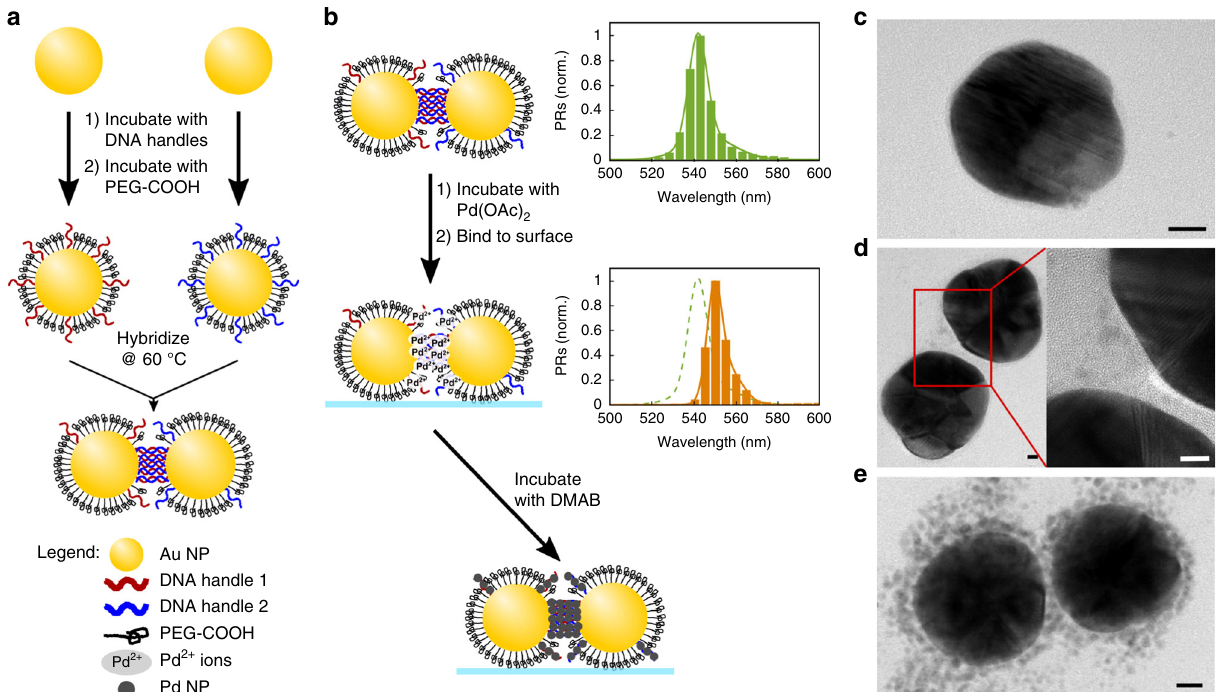
Fig. 1 DNA-guided growth of Pd NPs in plasmon rulers. a Model for plasmon ruler (PR) assembly from Au NPs functionalized with a low number of DNA molecules incorporated into a monolayer of PEG-COOH for colloidal stability. b Integration of Pd NPs. Pd 2 + binds to DNA and is subsequently reduced through the reducing agent DMAB. Distributions of the plasmon resonance wavelength of PRs before and after Pd 2 + binding are included as green and orange histograms, respectively. c TEM image of PEGylated NP control (scale bar = 10 nm). d TEM image of PR with low Pd NP loading after reduction of Pd 2 + . (scale bars = 5 nm). e TEM image of PR with high Pd NP loading after reduction of Pd 2 + (scale bar = 10